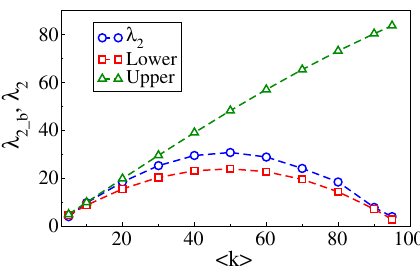
Fig. 3 Numerical value of (cid:31) 2 (blue) for 1D lattice with k /2 nearest neighbour couplings, its upper (green) and lower bound (red) as a function of the average degree. Here, N